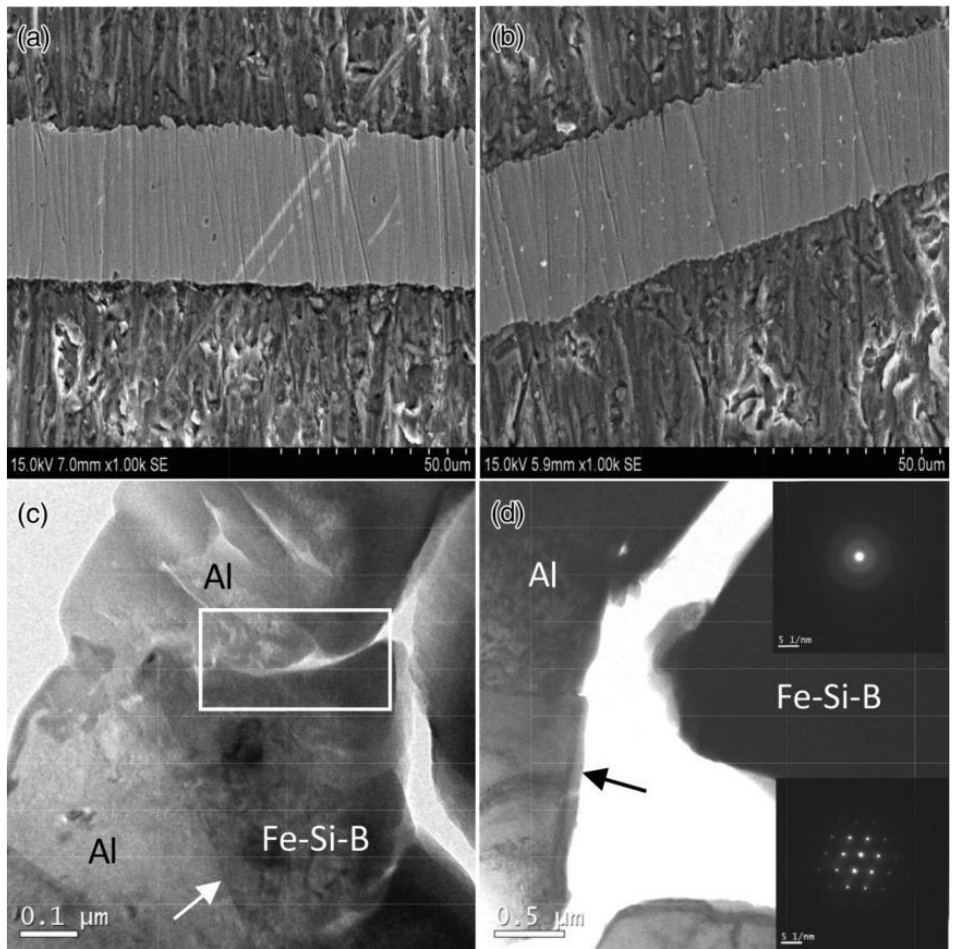
Figure 3. High- and low-magnification SEM photos and TEM bright field images of the Al/Fe 80 Si 9 B 11 /Al composite plate after roll bonding at an initial temperature of 450 °C and deformation 80%. ( a ) Al/5% Fe 80 Si 9 B 11 /Al; ( b ) Al/10% Fe 80 Si 9 B 11 /Al; ( c , d ) Al/10%Fe 80 Si 9 B 11 /Al.3.2. High-Pressure Torsion.